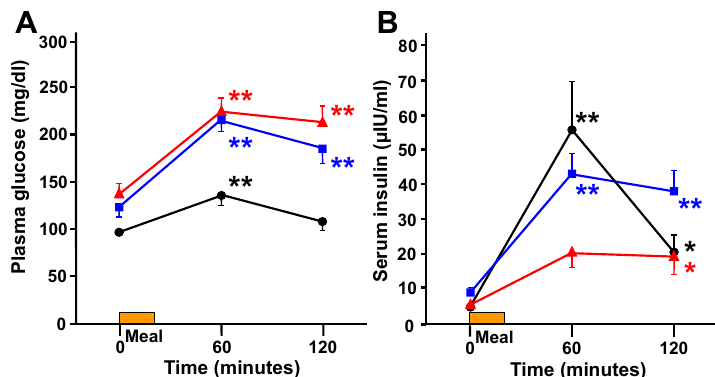
Figure 3. Changes in plasma glucose ( A ) and serum insulin ( B ) during the meal tolerance test. The control group is indicated by the black line and circles (●); the mild group by the blue line and squares ( ■ ); and the severe group by the red line and triangles ( ▲ ). ** p < 0.01, * p < 0.05 vs. 0 min.